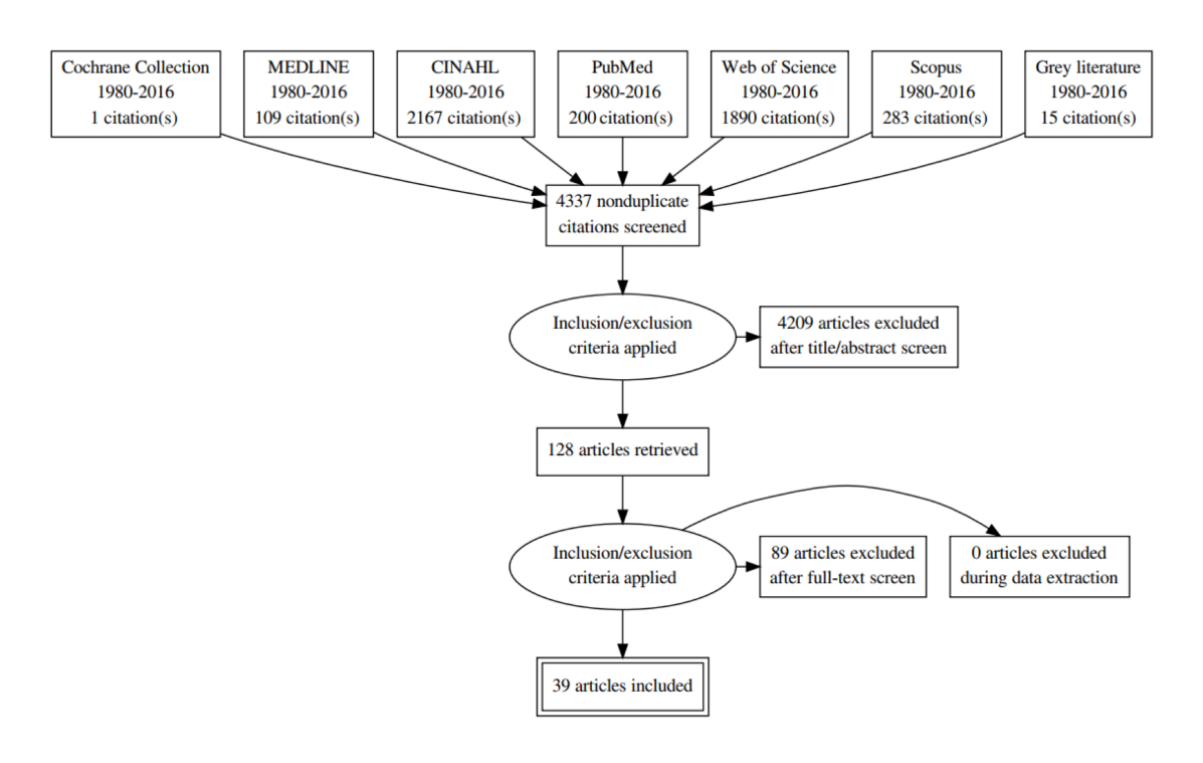
Figure 1. Flow of the citations reviewed as part of the systematic review